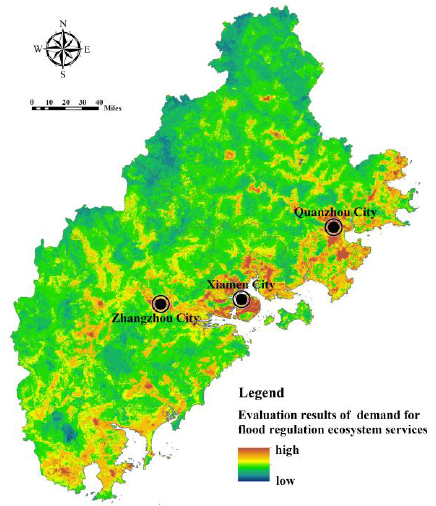
Figure 12. Assessment of the demand for FRES in Fujian Delta.